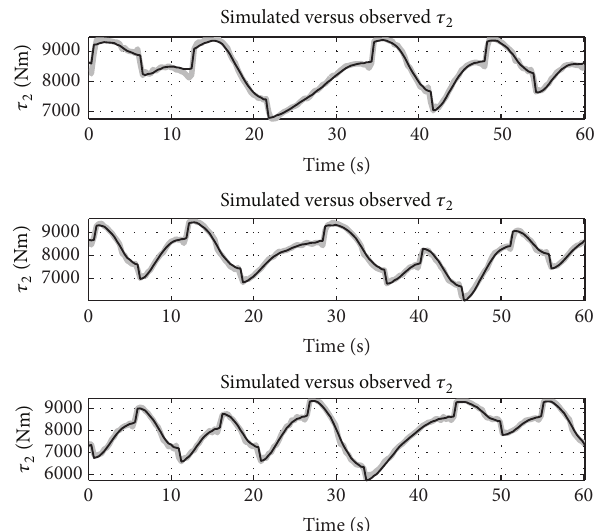
Figure 7: Result of validation for three different recorded sets of data. The plot shows the simulated response of the input torque 𝜏 2 (𝑡) in (Nm) (dark bold line) versus the measured one (grey